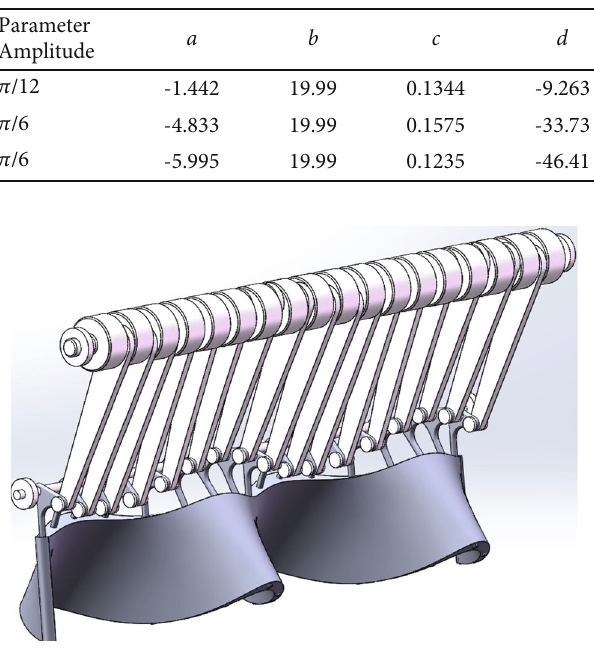
Figure 20: Mechanism assembly